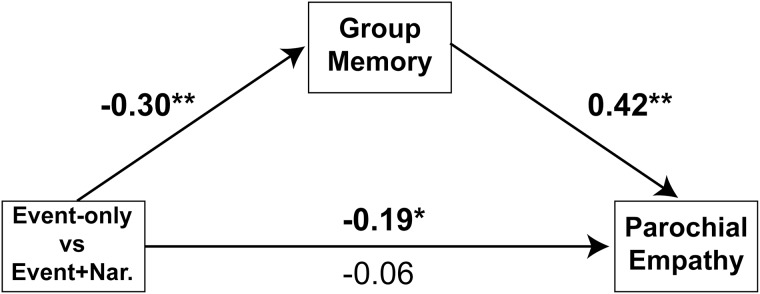
Memory for group membership mediates the relationship between condition (event-only versus event+narrative) and parochial empathy.